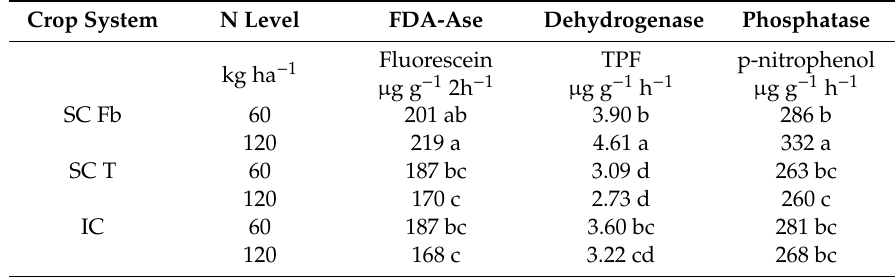
Table 11. FDA-ase, dehydrogenase and alkaline phosphatase in the soil of full treatments, as affected by the Crop system × N level interaction. SC, sole crop; IC, intercrop. Values followed by the same letter within a column are not significantly different at P < 0.05, Tukey’s test. Crop System N Level